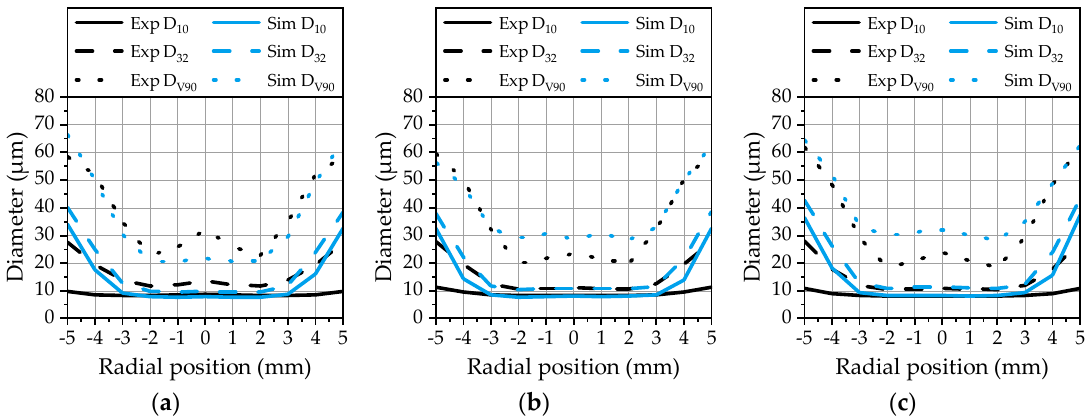
Figure 13. Arithmetic diameter, Sauter mean diameter and diameter at the 90% volumetric quantile in the radial direction for OP 1 ( a ), OP 2 ( b ) and OP 3 ( c ).